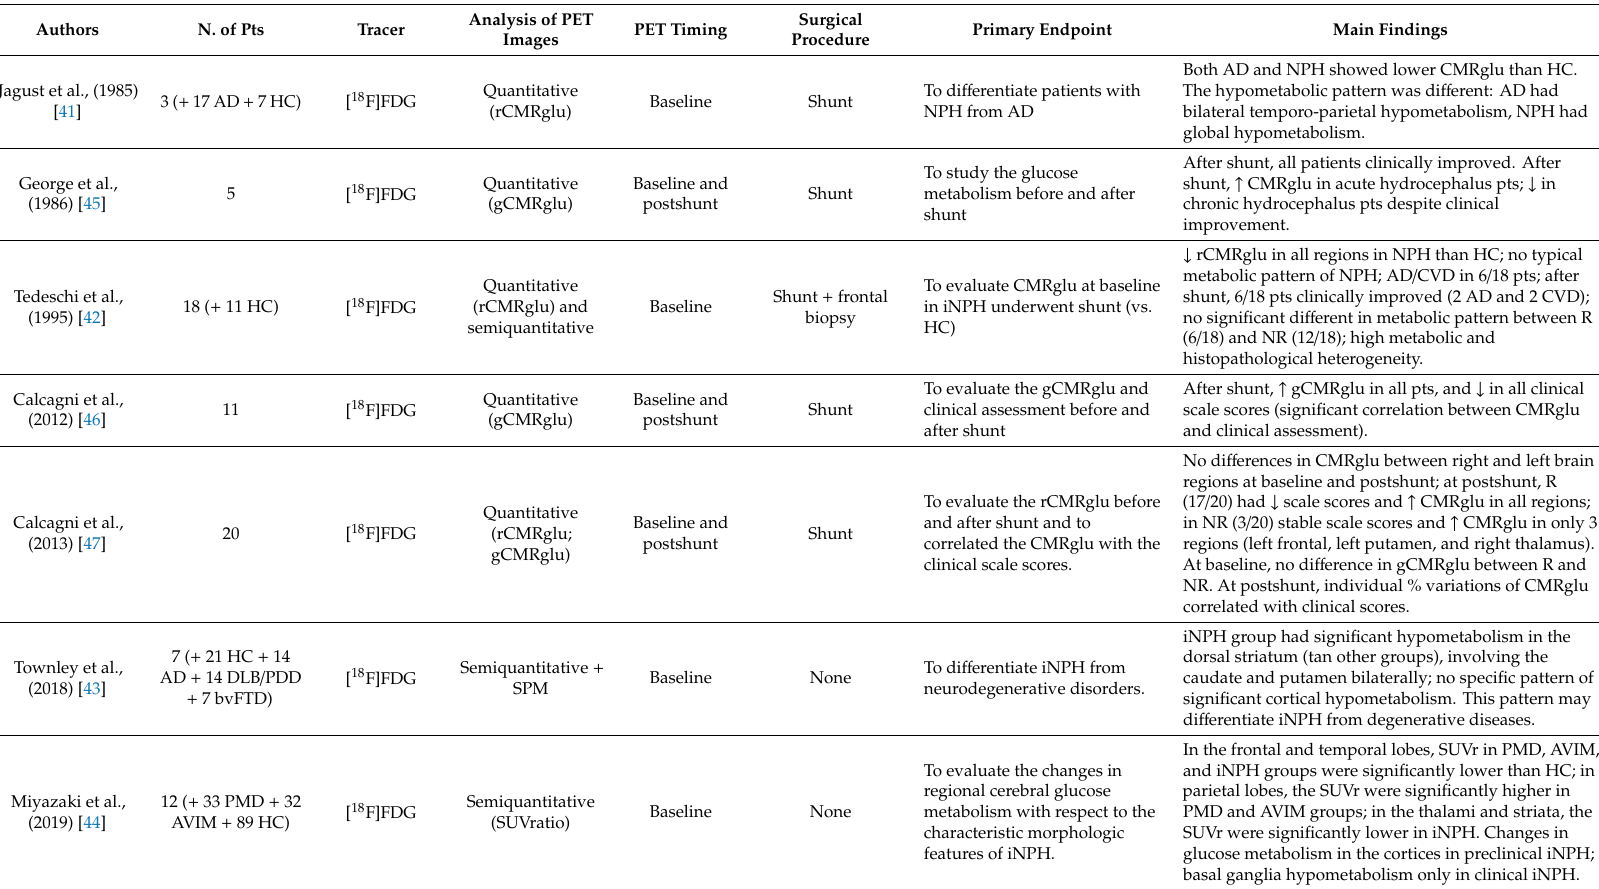
Table 3. Glucose metabolism PET imaging in NPH